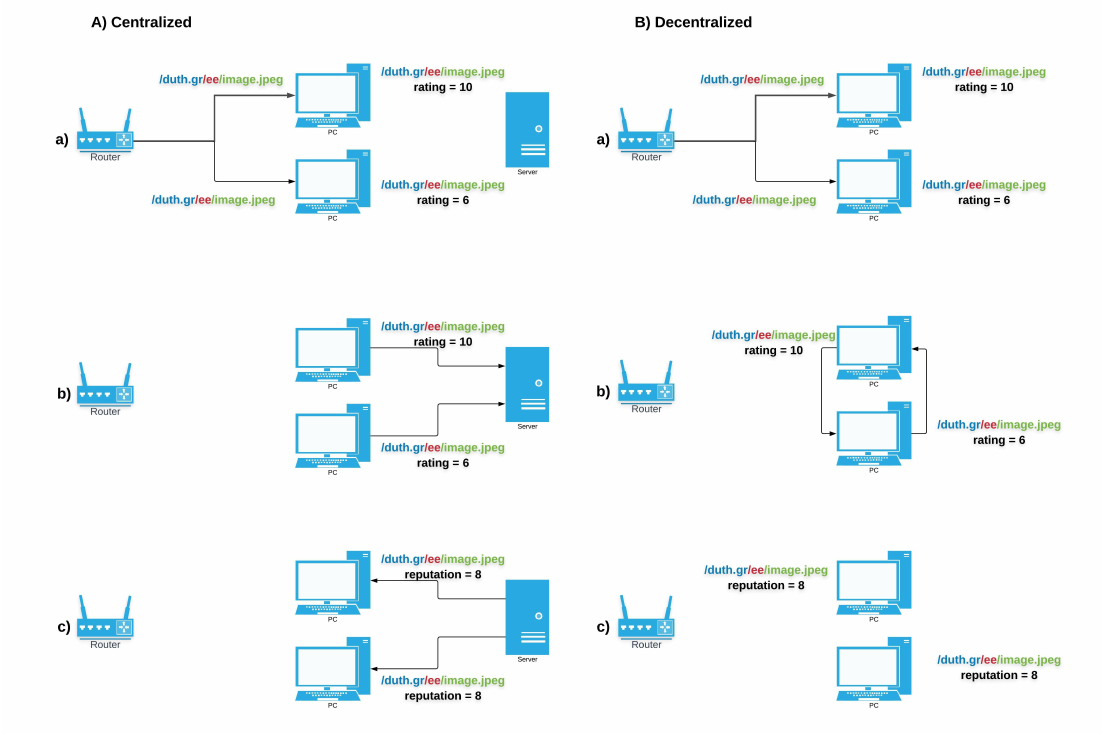
Figure 2. Centralized vs Decentralized: ( A ) Centralized: ( a ) Receiving content & assigning ratings, ( b ) Sending ratings to a CA, and ( c ) CA computing & announcing reputation value. ( B ) Decentralized: ( a ) Receiving content & assigning ratings, ( b ) Exchanging ratings, and ( c ) Computing reputation value